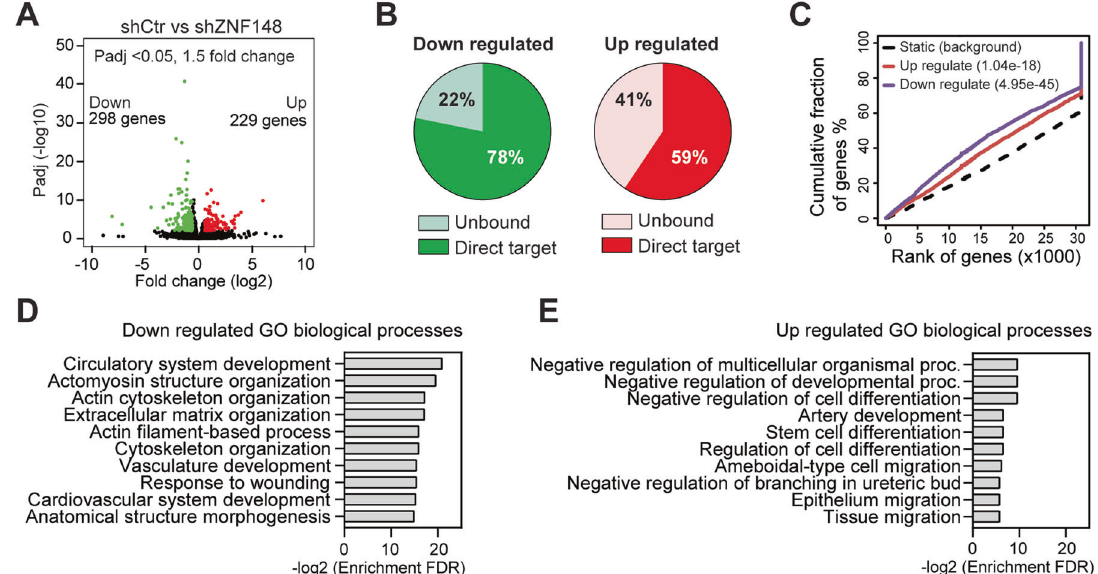
Fig. 5 Transcriptome analysis of ZNF148 knockdown cells. A Volcano plot showing 229 upregulated (>1.5 fold) genes depicted in red and 298 downregulated (<1.5 fold) genes depicted in green (Padj < 0.05). B Pie charts showing the percentage of ZNF148-bound direct target genes or the unbound genes in up- or downregulated genes upon ZNF148 knockdown in MDA-MB-231 cells. C Transcription factor activating and repressive function prediction by BETA [44]. The upregulated (red line) and downregulated (purple line) ZNF148 target genes are cumulated by the rank on the basis of the regulatory potential score from high to low ( X -axis). Both the up- or downregulated genes are signi fi cantly distributed above the non-differentially expressed static background (dashed line) by the Kolmogorov – Smirnov test [44]. D GO biological process analysis of downregulated genes from “ A ” . E As in “ D ” for the upregulated